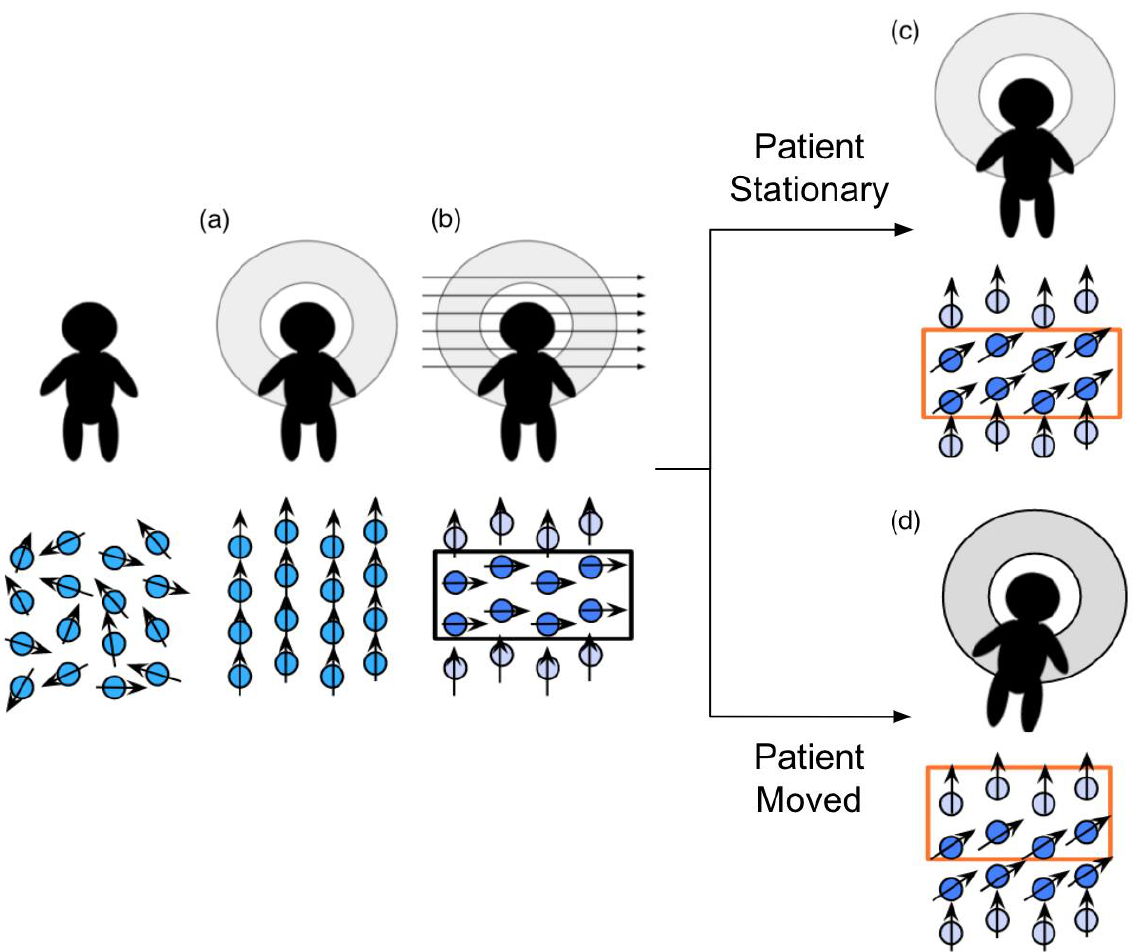
Figure 2. The process by which patient movement causes the spin history effect. When the patient enters the scanner, ( a ) all molecules with any polarity align to the magnetic field. ( b ) An RF excitation pulse is applied to a limited volumetric space within the patient, forcing those molecules to align with the temporary, secondary magnetic field. When the patient is stationary ( c ), the MR scanner records EM signals from those excited molecules. If the patient moves ( d ), the MR scanner records EM signals from a mix of intentionally excited and previously excited